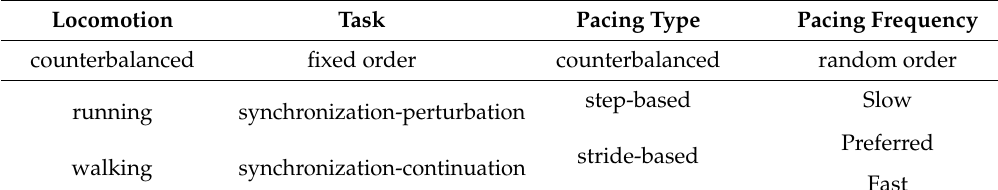
Table 1. Overview of the di ff erent conditions and the order of these conditions.